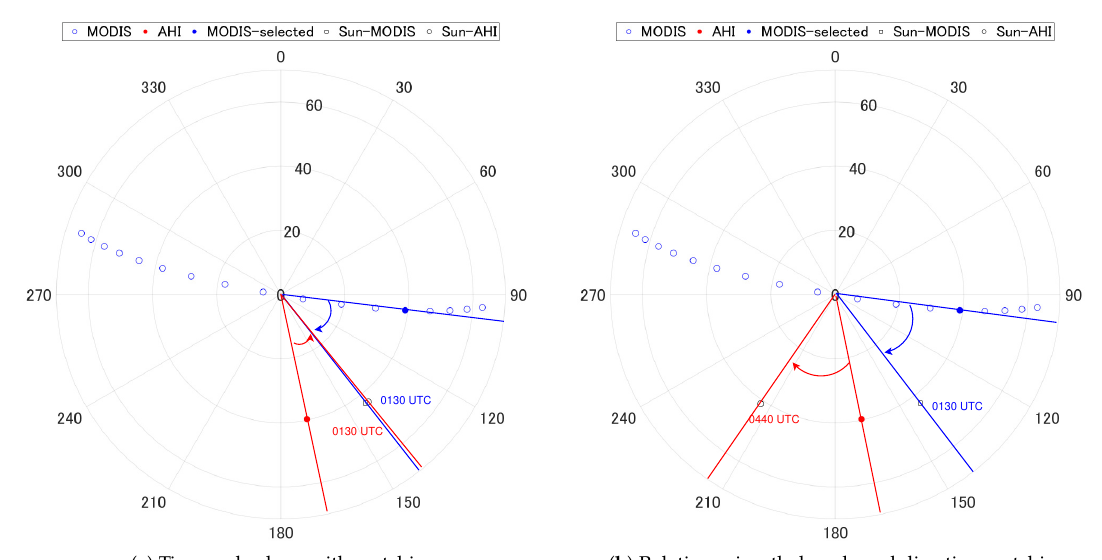
Figure 2. Angular conditions of the sun, MODIS, and AHI for the SZM method ( a ) and RAM method ( b ) over the ROI of the Kochi Forest. The observation data for this plot span the period between 1 and 16 March (16 days) 2018. The time difference is minimal in ( a ) but the relative azimuth angles are not identical. The relative azimuth angles are almost identical in ( b ), but the time difference is